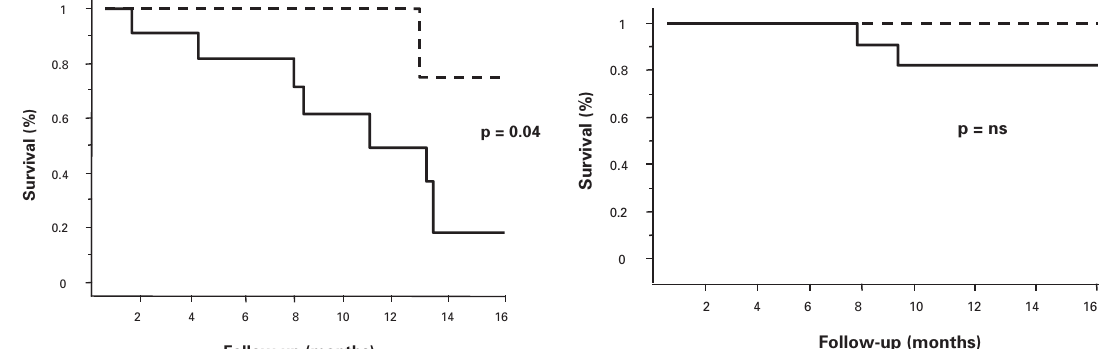
Kaplan Meier survival curve of patients with coronary artery disease divided into patients with CRT device (bold line) and patients with combined CRT-ICD device (dotted line). Nine patients out of 22 patients with CAD died.